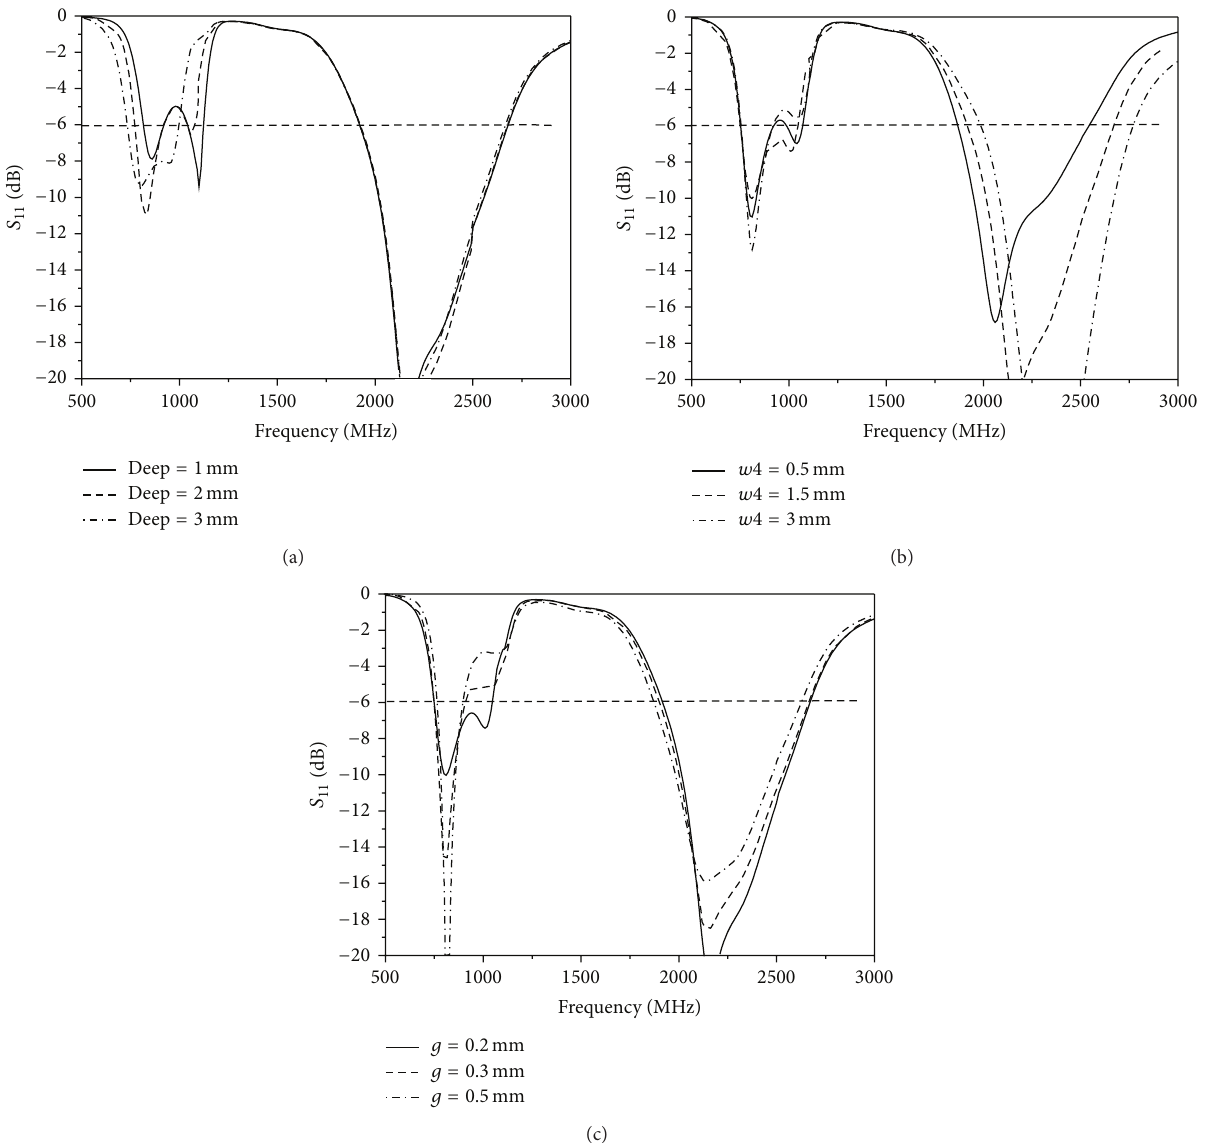
Figure 2: Variation of the return loss of the unit element of the proposed MIMO antenna with the increase of geometry parameters: (a) deep, (b) w 4, and (c) g